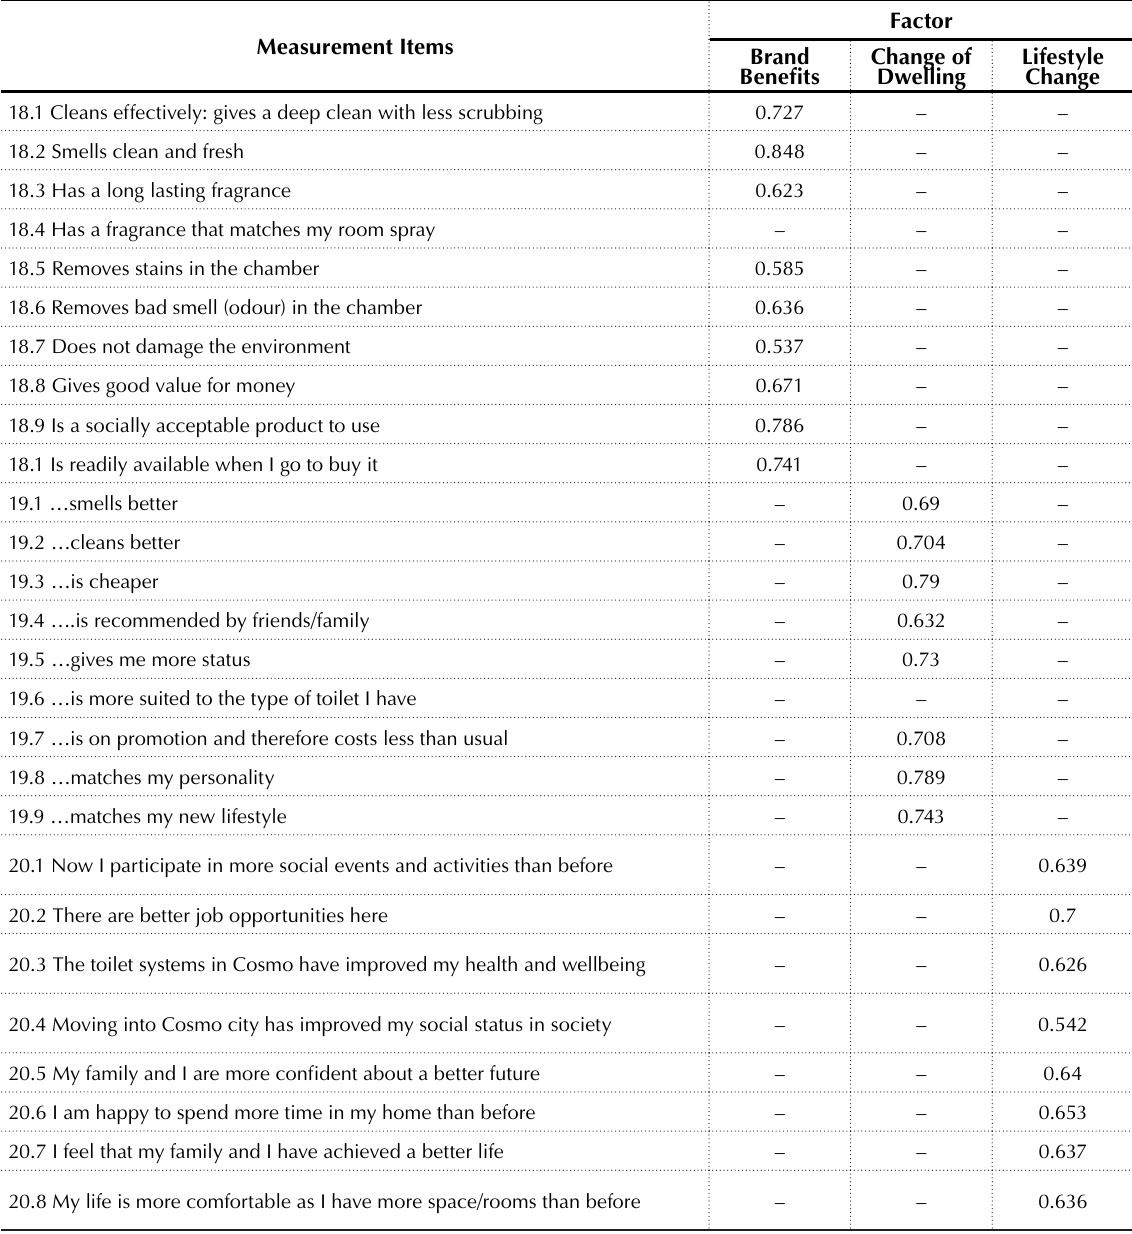
Table 4. Rotated factor